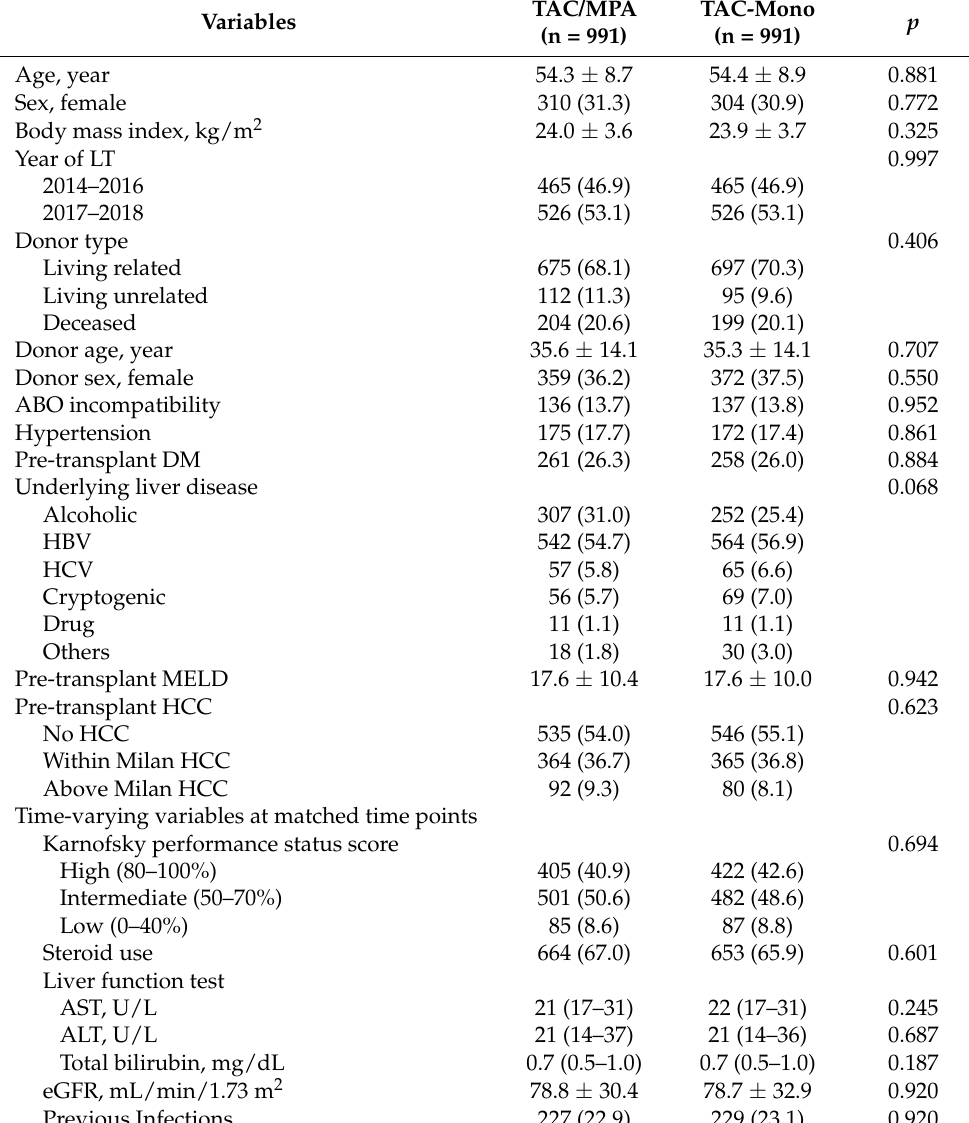
Table 1. Baseline characteristics in matched